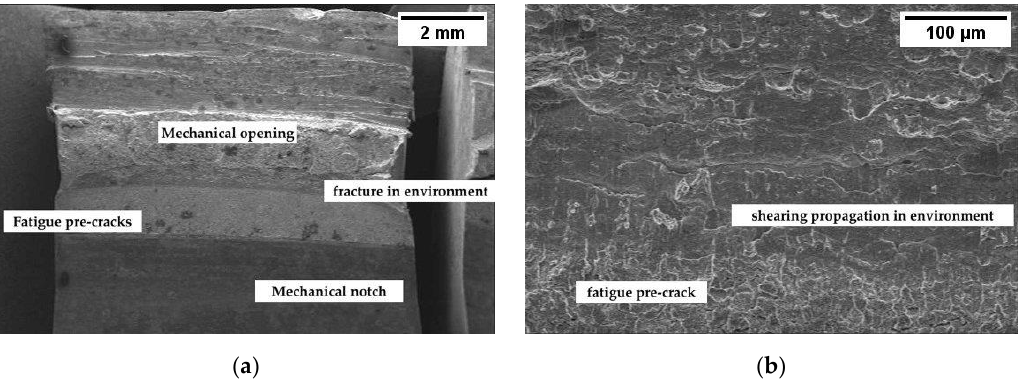
Figure 5. Fracture surface in J-integral test for X100 steel at free corrosion potential: ( a ) macro and ( b ) close-up view of the crack propagation zone.